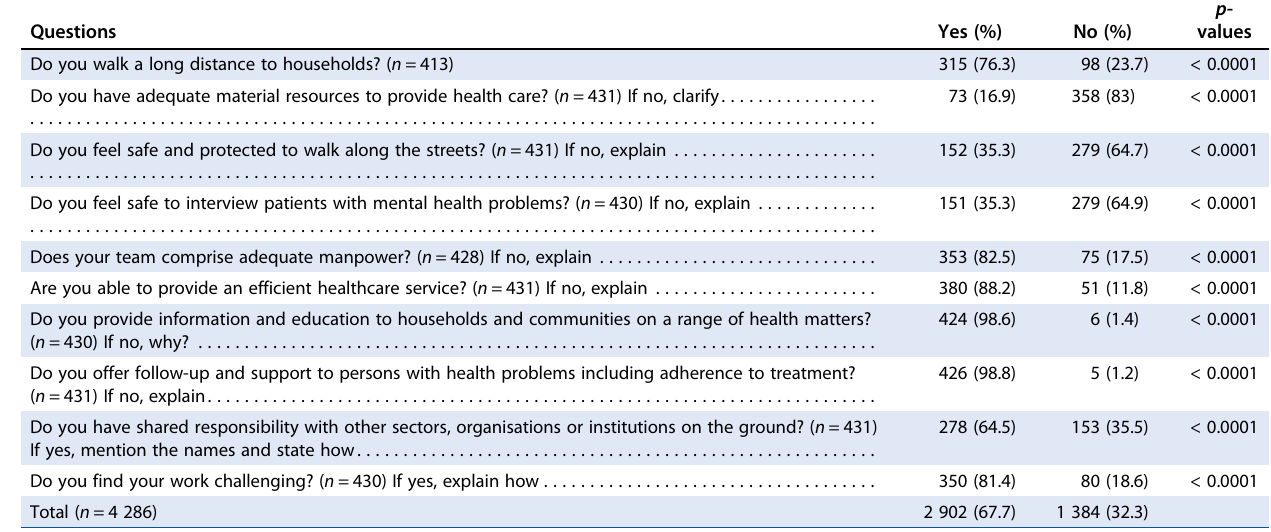
Table 4: CHWs ’ practice regarding WBOT services